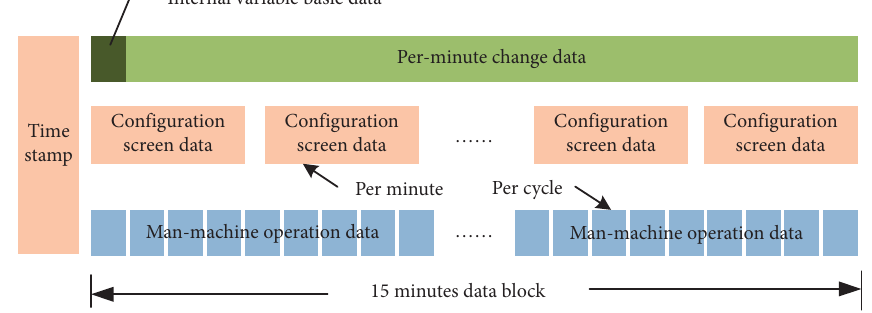
Figure 11: Data structure of the SVDU simulator.